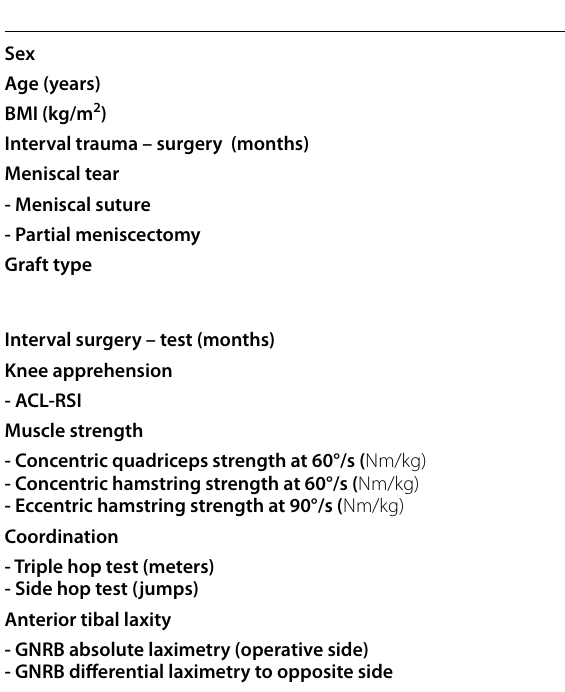
BMI Body mass index, ACL-RSI Anterior cruciate ligament return to sport after injury, LSI Limb symetry